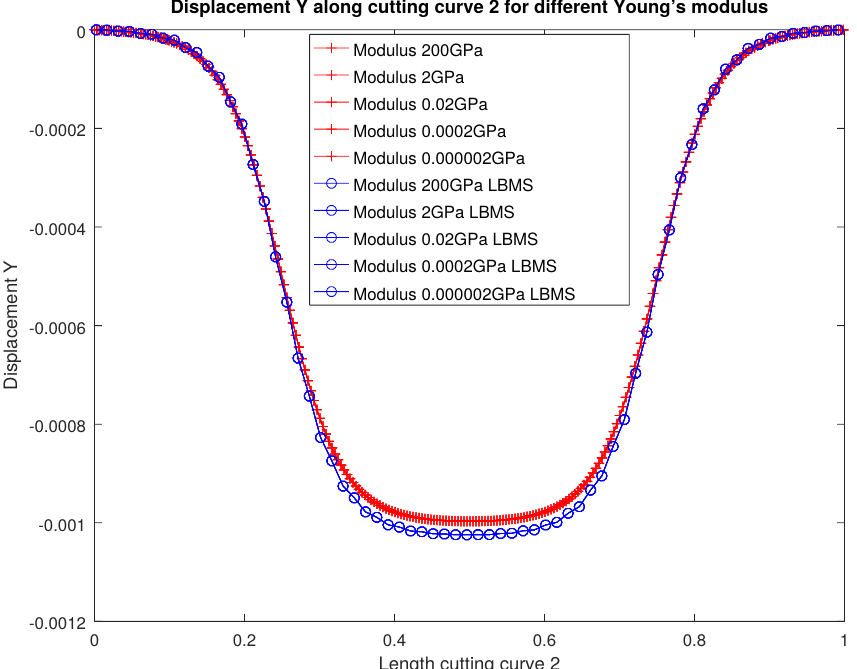
Figure A18. Second displacement components along cutting curve C 2 for different Young’s